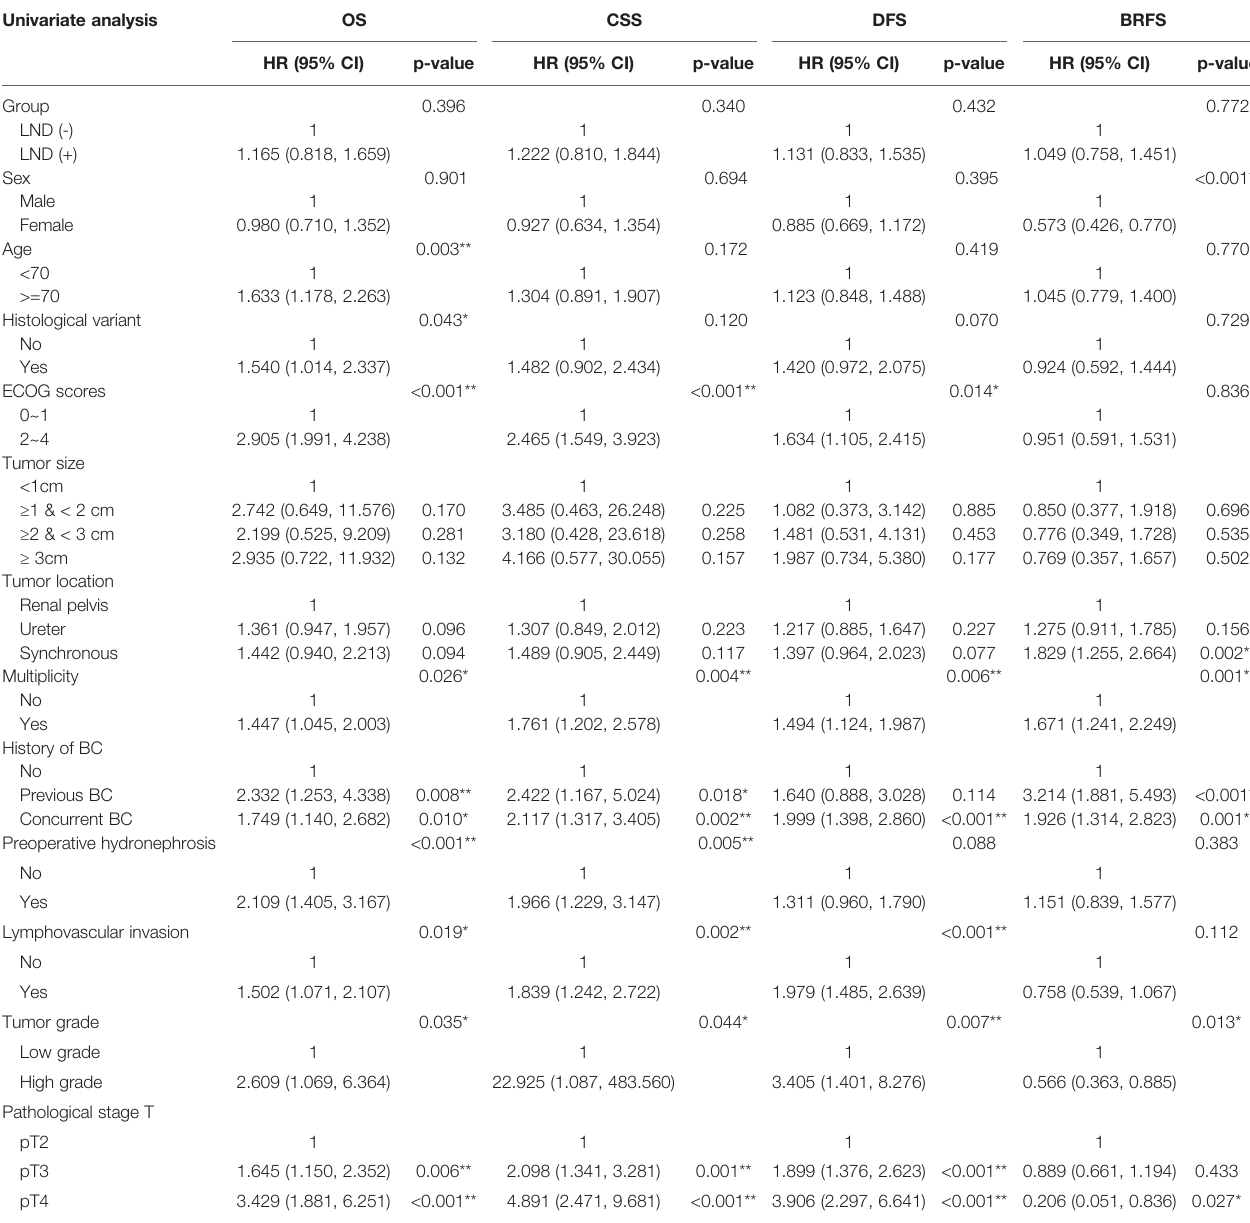
TABLE 2 | Comparative univariate survival analysis of UTUC patients receiving NU. Univariate